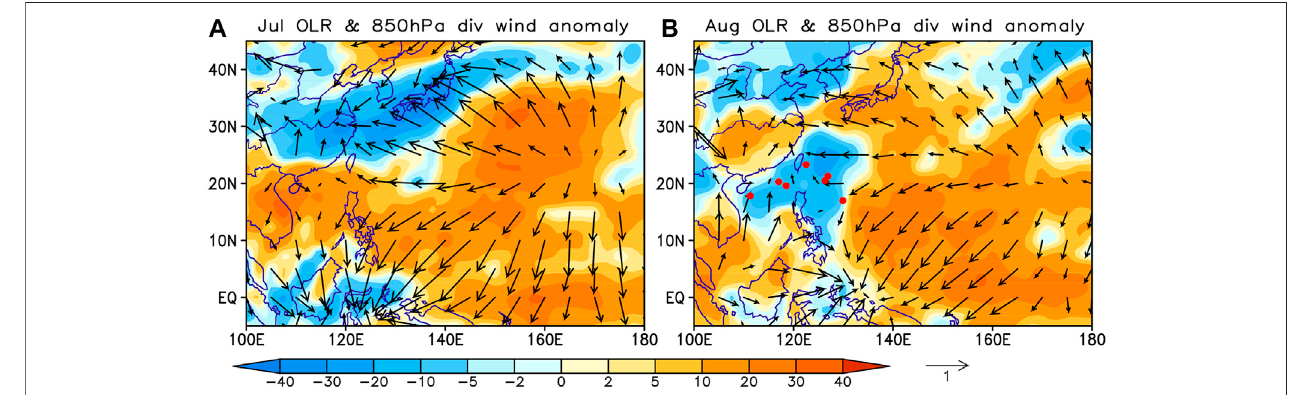
FIGURE7|(A) OLR(shading,Wm − 2 )and (B) 850-hPadivergentwinds(vector,m s − 1 )anomaliesinJulyandAugust2020,respectively.Thereddotsin (B) indicate the locations of TC